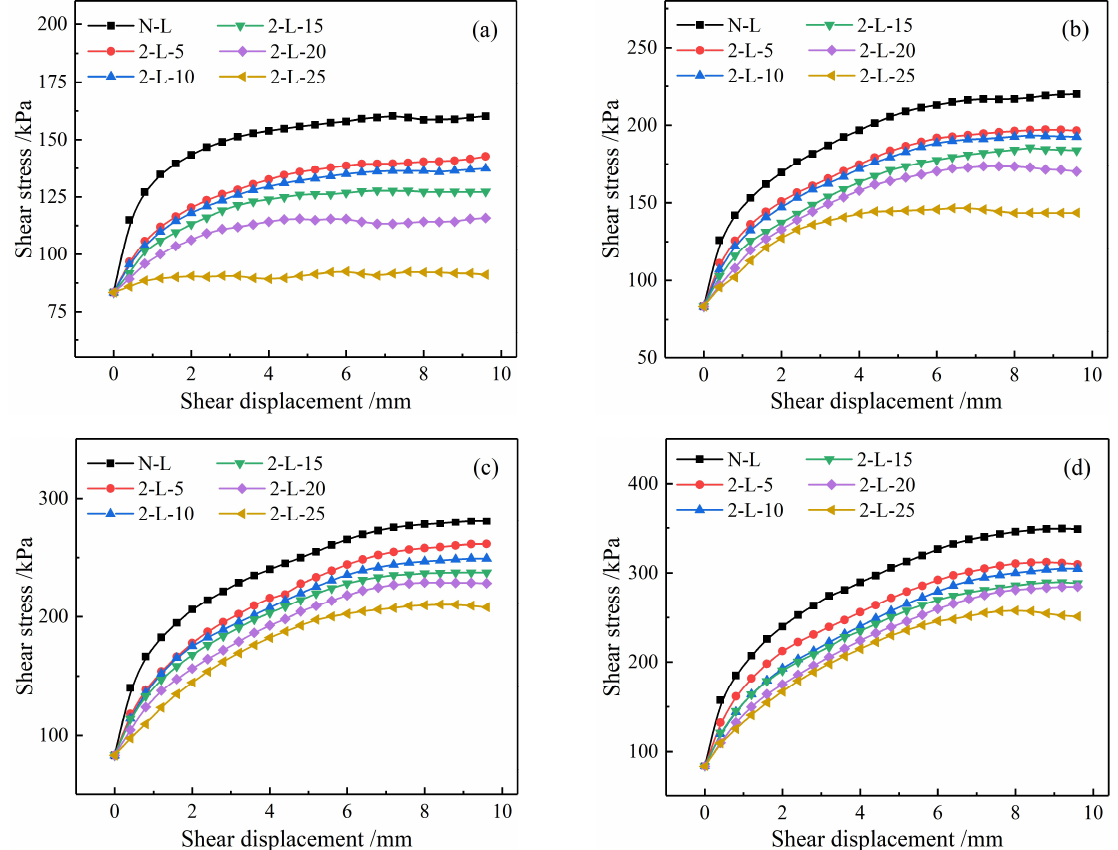
Figure 8. Effect of layered angle on the τ - δ curve: ( a ) 100 kPa; ( b ) 200 kPa; ( c ) 300 kPa; ( d ) 400 kPa.